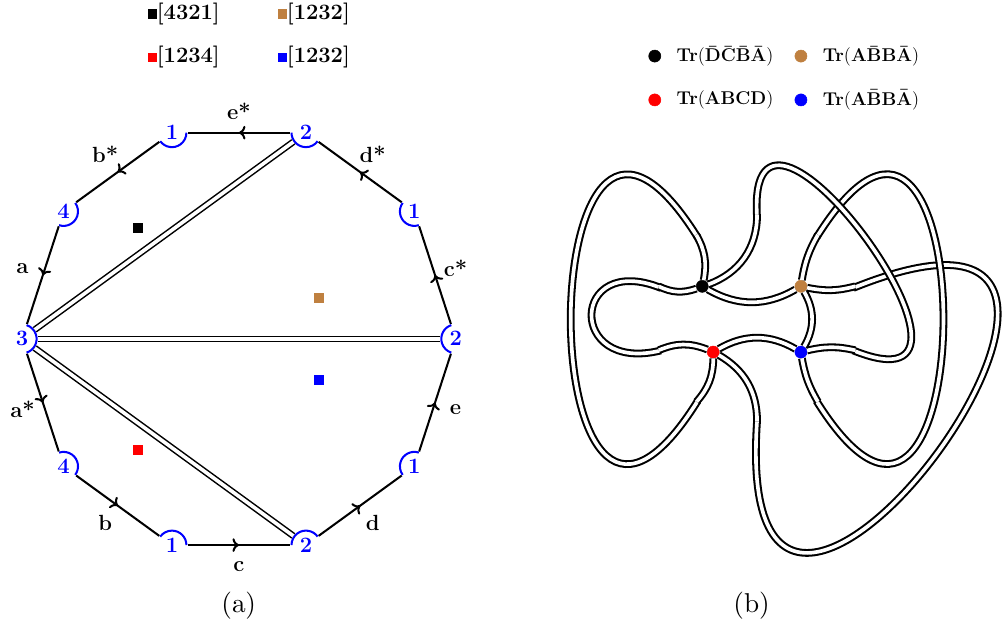
Figure 15 . A genus-one quadrangulation and its graph dual as Wick contractions of four-valent vertices.